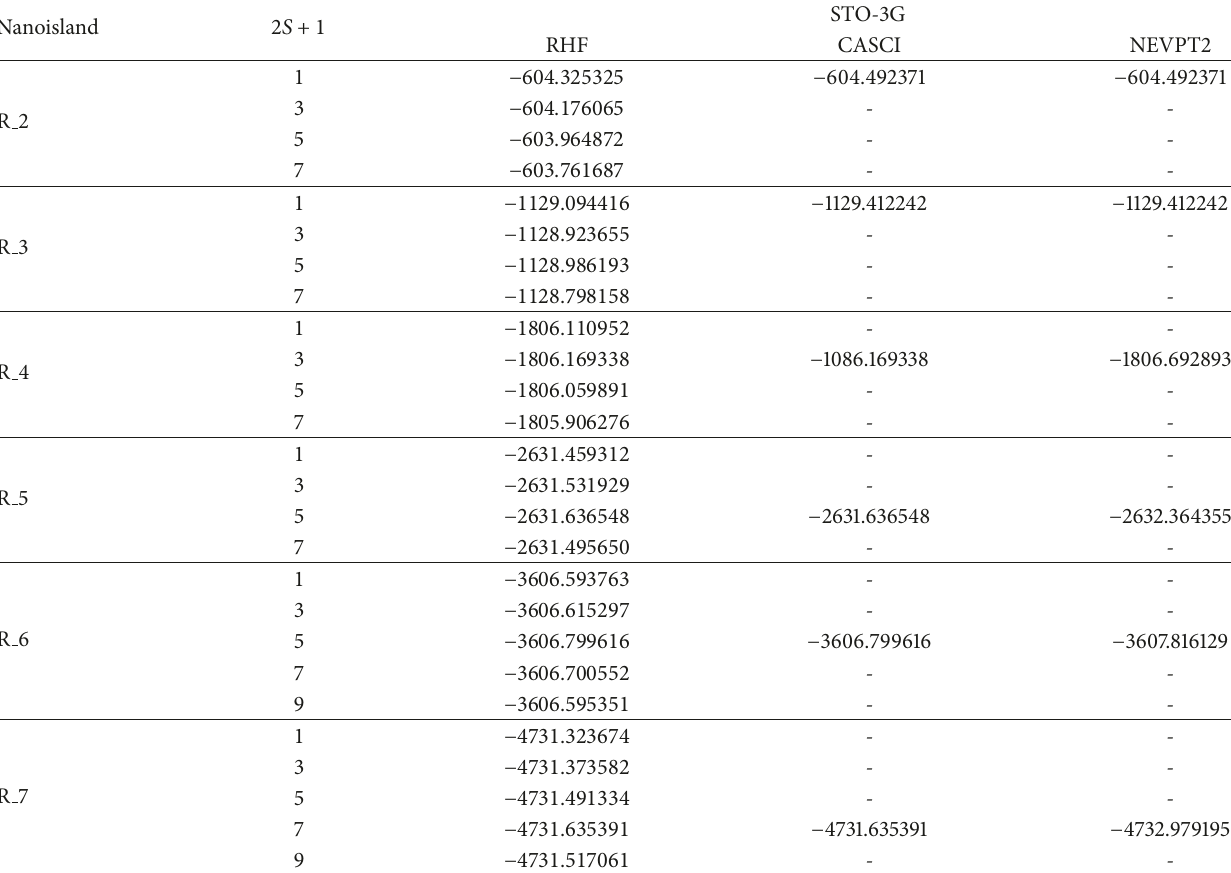
Table 1: Energies for the different rhombuses nanoislands in